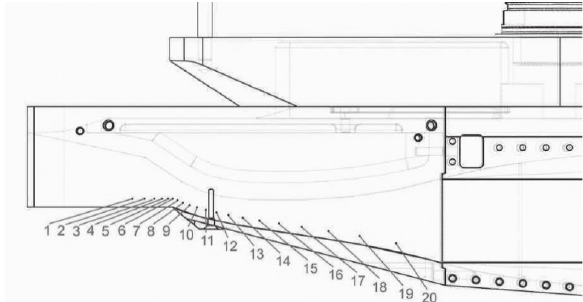
Figure 5. Th e static pressure taps on the intake diff user side surface diagram